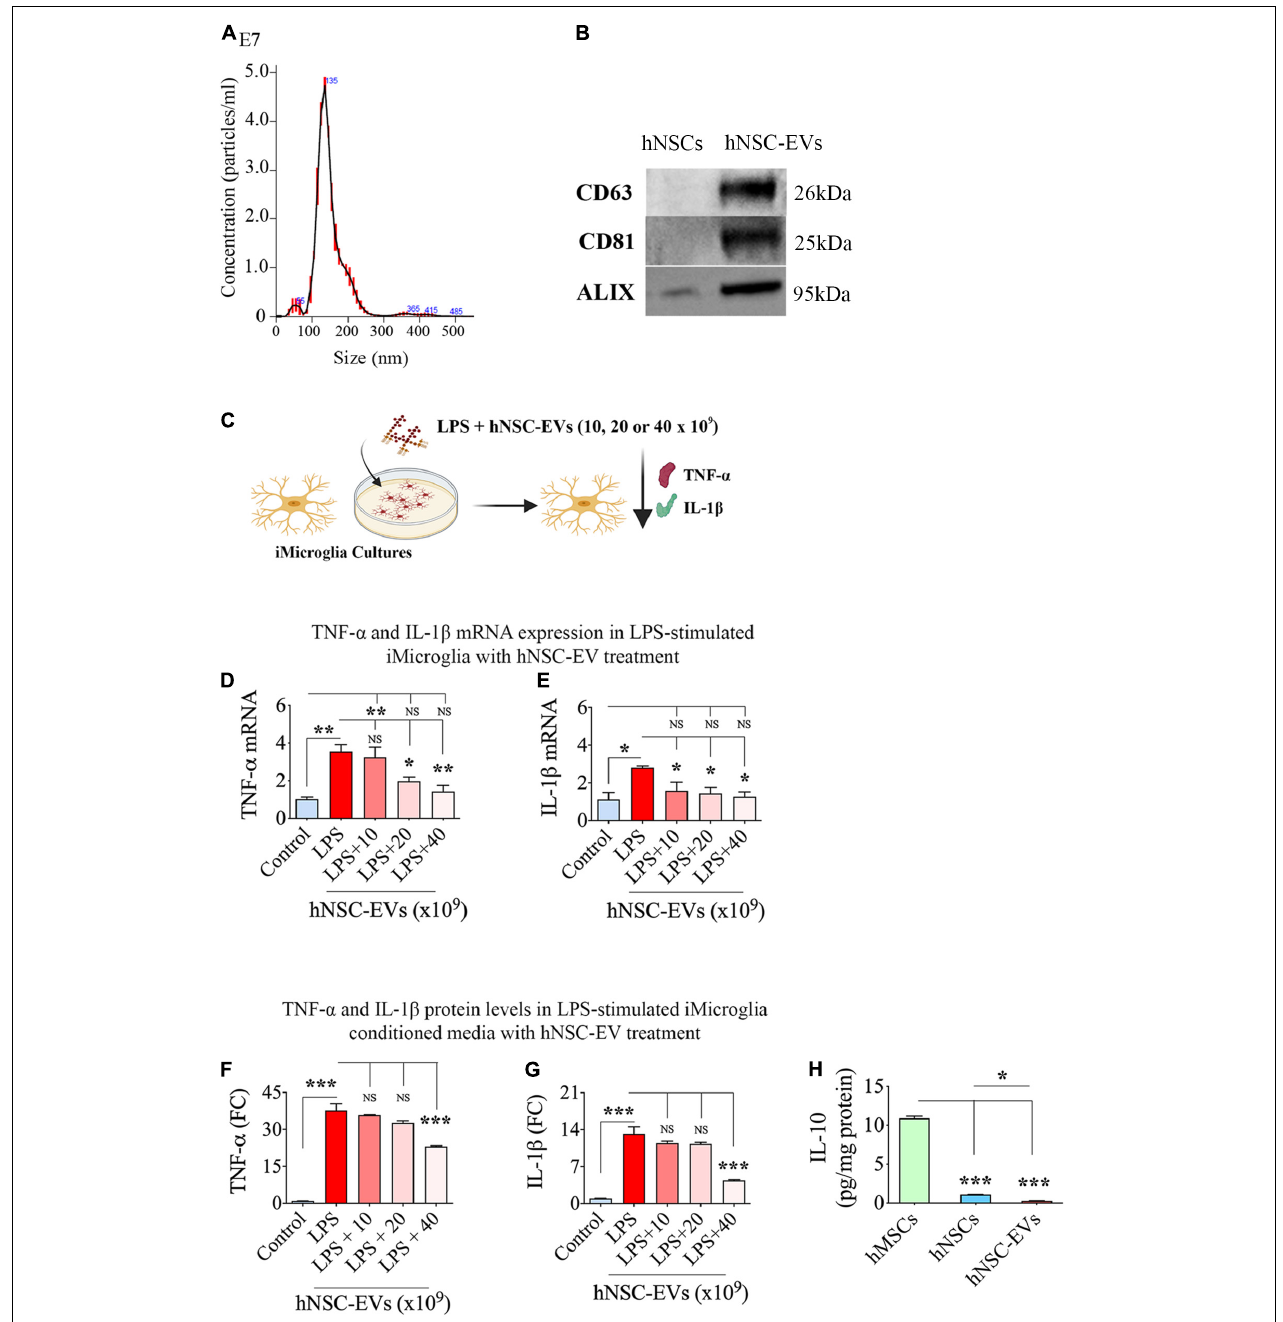
FIGURE 4 | Size and marker expression in human neural stem cell-derived extracellular vesicles (hNSC-EVs) and antiinflammatory activity of hNSC-EVs. (A) Shows the size of hNSC-EVs measured through nanoparticle tracking analysis. (B) Illustrates western blot images of EV-specific markers CD63, CD81, and ALIX in hNSCs and hNSC-EVs. (C) Is a schematic showing the experimental design testing the antiinflammatory effect of hNSC-EVs. The bar charts in (D,E) show greatly enhanced tumor necrosis factor-alpha (TNF- α ) and interleukin-1 beta (IL-1 β ) mRNA expression in iMicroglia with lipopolysaccharide (LPS) treatment alone and diminished TNF- α and IL-1 β mRNA expression in iMicroglia with LPS plus hNSC-EV treatment. While only higher doses of hNSC-EV treatment (20 or 40 × 10 9 EVs) normalized TNF- α mRNA expression (D) , all doses of hNSC-EV treatment tested (10, 20, or 40 × 10 9 EVs) normalized IL-1 β mRNA expression (E) . The bar charts in (F,G) show elevated TNF- α , and IL-1 β protein levels in LPS-stimulated iMicroglia conditioned media and significantly diminished TNF- α and IL-1 β protein concentrations in the conditioned media of LPS-stimulated iMicroglia receiving 40 × 10 9 EVs treatment. (H) Shows the concentration of IL-10 in hNSCs and hNSC-EVs compared to human mesenchymal stem cells (hMSCs). * p < 0.05, ** p < 0.01, *** p < 0.001, NS, not significant.